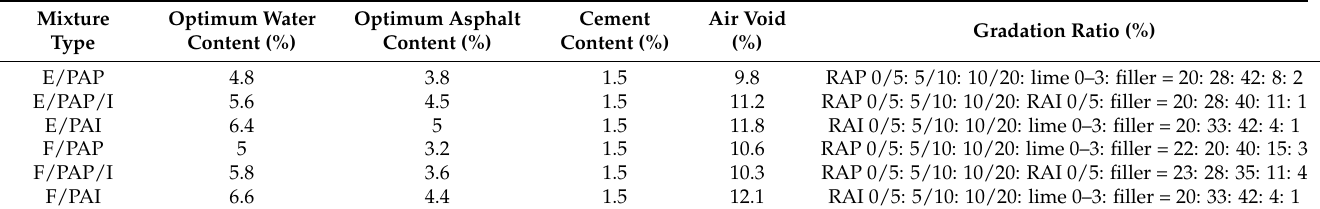
Table 3. Mixture design results of